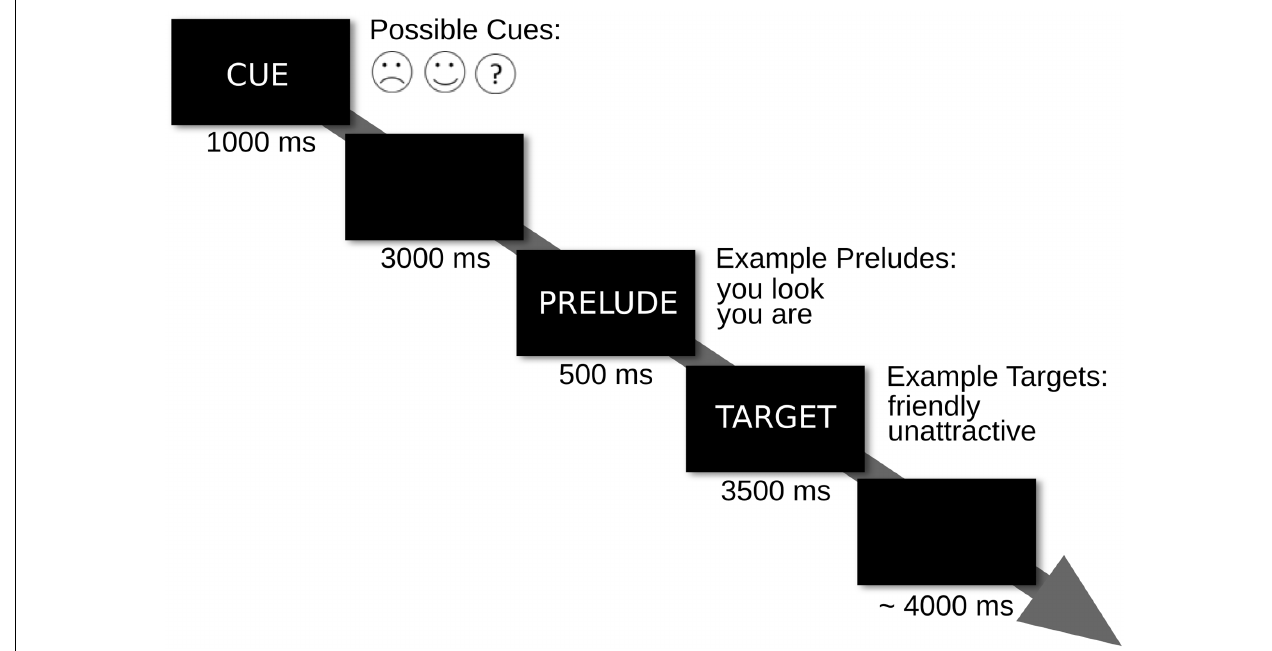
FIGURE 1 | Trial outline. Trial events and their respective durations are illustrated.